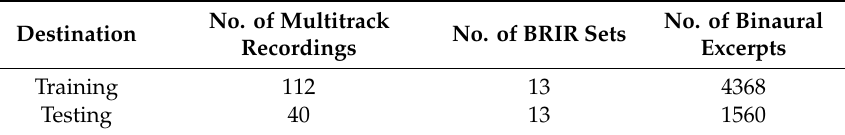
Table 1. Constitution of the binaural audio repository (adapted from [34]).